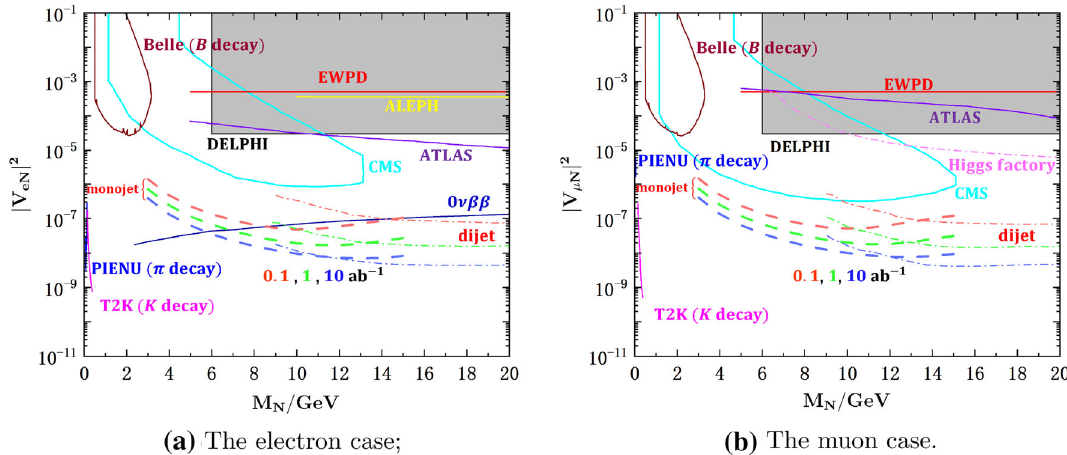
Fig. 5 The upper bounds on | V (cid:3) N | 2 at 95% CL from future Z -factories with three setups of integrated luminosities L = 0 . 1 , 1 and 10 ab − 1 . Constraints from other experiments are also displayed for compari- son, including direct searches by ALEPH [49], DELPHI [50], CMS [29] and ATLAS [28], indirect searches like 0 νββ [33], electroweak precision data (EWPD) [53], and meson decays measured by PIENU